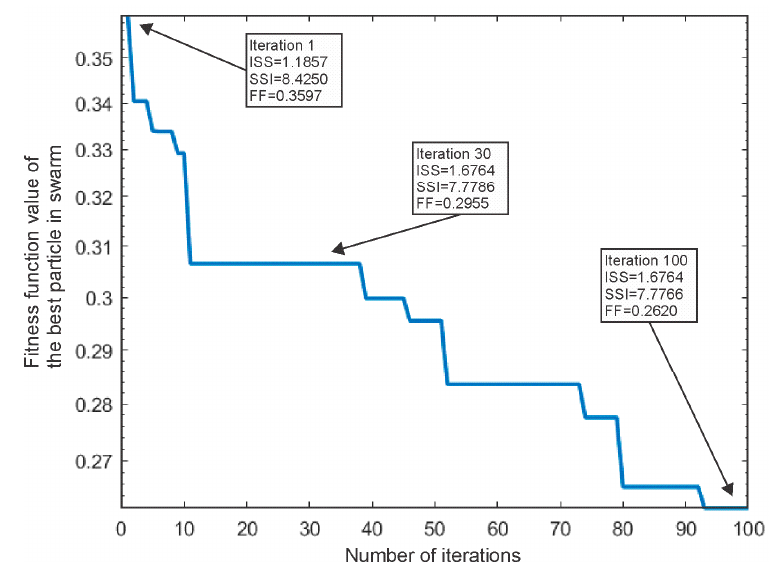
Figure 8. Convergence of the solution. ISS stands for initial step size, SSI for step size increase and FF for fitness function represented by the testing RMSE.